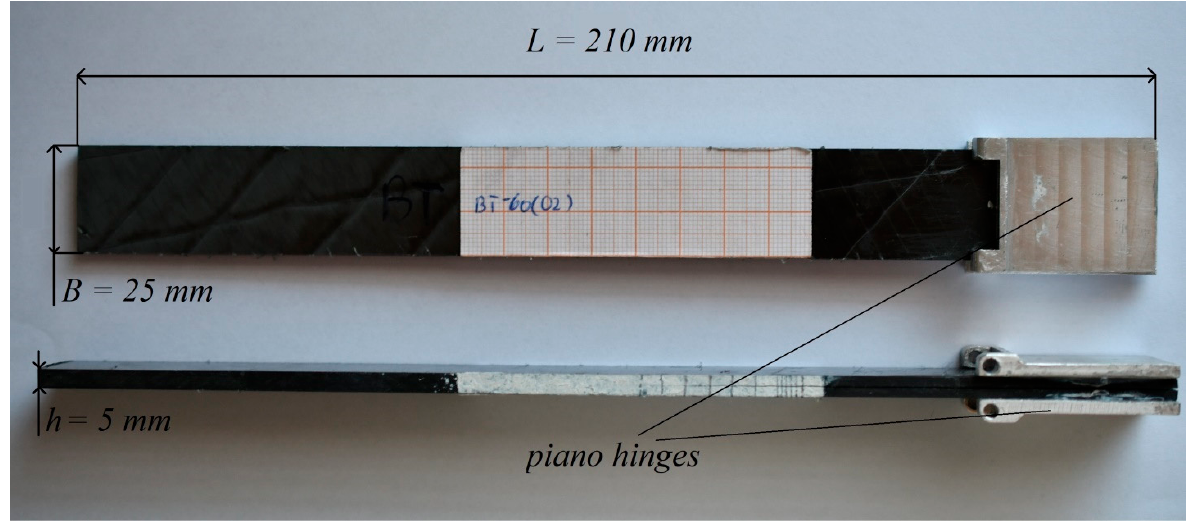
Figure 1. Main dimensions of experimentally tested laminates.